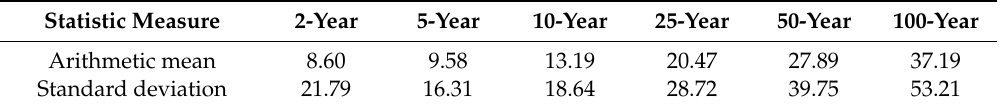
Table 5. Arithmetic mean and standard deviation for the relative changes of the return levels across all six models and for the two RCP scenarios in comparison with the respective historical model runs. All values represent changes in